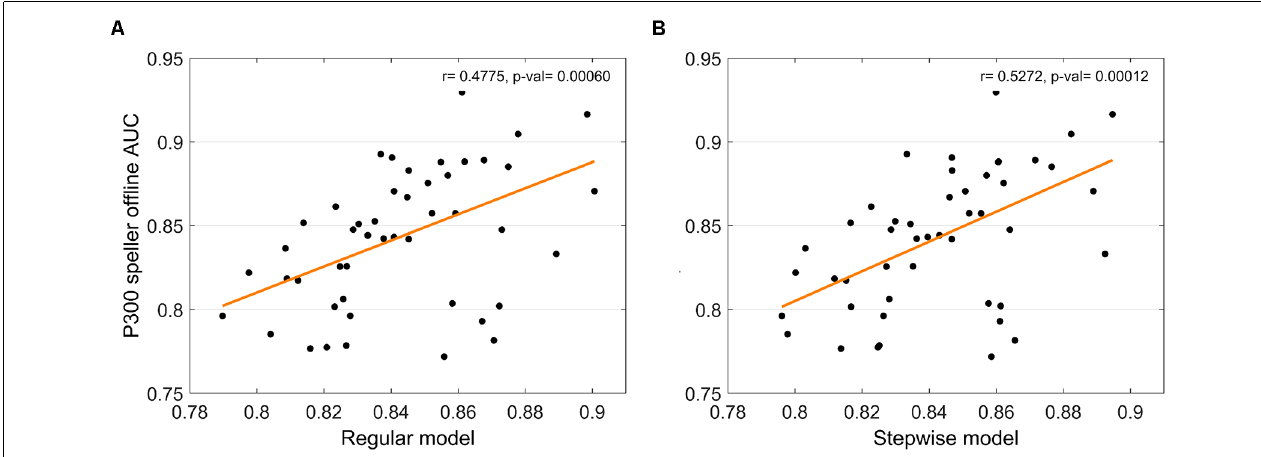
FIGURE 6 | Relation between multi-feature predictors and P300 speller performance. The relationship with P300 speller performance are displayed for the multi-feature regular model (A) and stepwise model (B) , respectively.